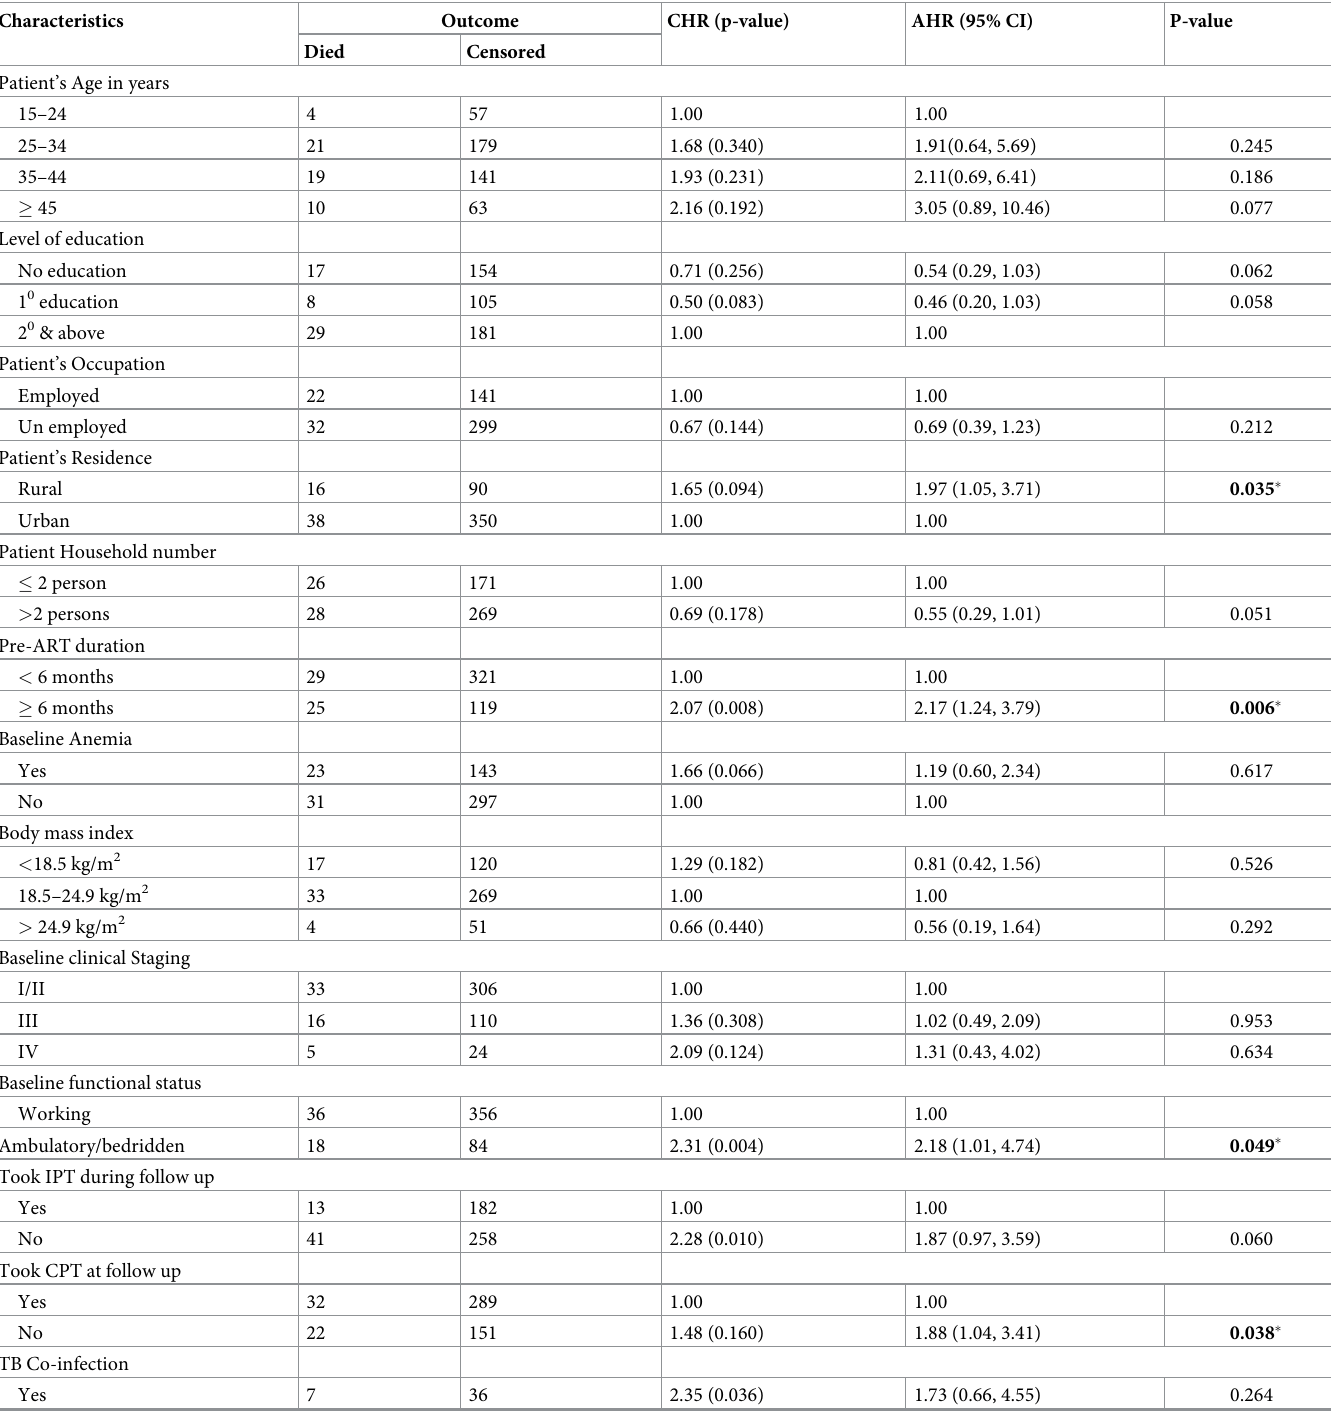
Table 3. Cox regression analysis of predictors of mortality within one year of ART initiation among adults on ART at Debre-Markos Referral Hospital; Jan 1, 2014 to Dec 31, 2018 (n = 494).